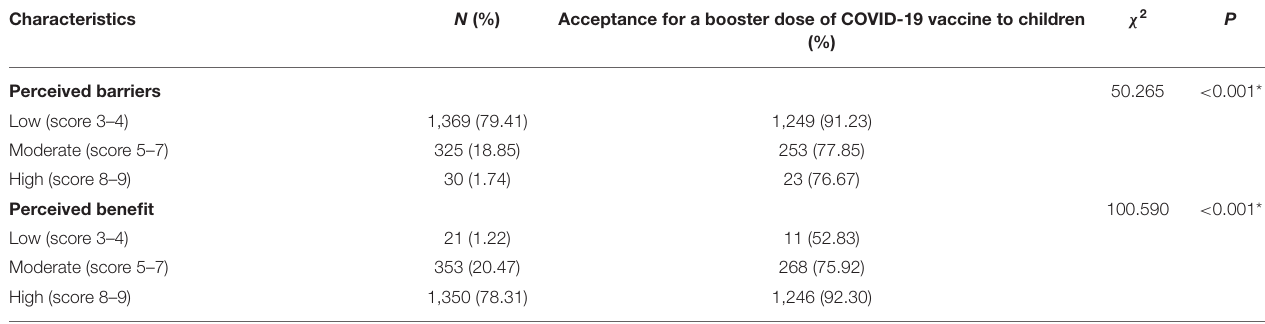
TABLE 2 | Risk perception among 1,724 child caregivers in China during COVID-19.